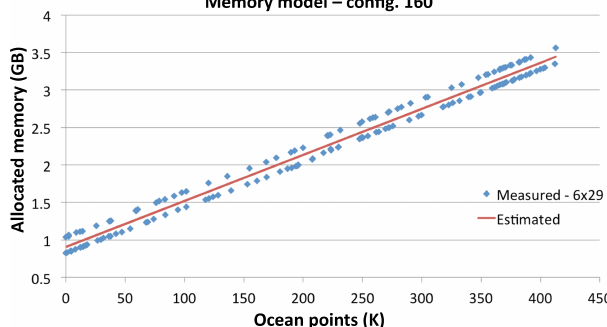
Figure 13. The relationship between the number of ocean points be- longing to a subdomain and the memory footprint needed to process that subdomain. The chart shows the data extracted from a refer- ence run on 672 processes (hence 672 subdomains) on the ATHENA cluster. The data have been used to evaluate the memory model co- efficients.